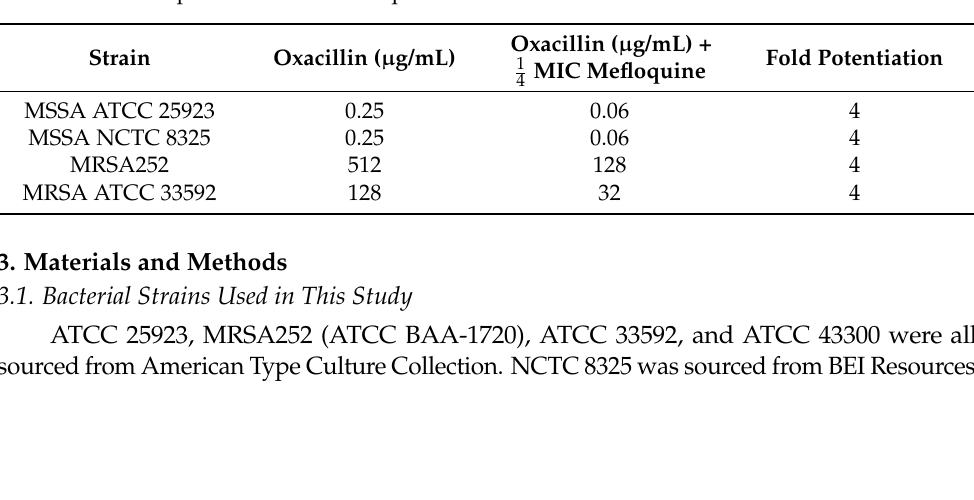
Figure 4. Compound effects on the cytoplasmic membrane of S. aureus. ( A ) SYTOX Green uptake induced by melittin or mefloquine treatment in ATCC 25923. Concentrations are indicated as fold of the MIC. The solid gray line indicates the RFU of the DMSO control. Signals are reported after 20 min of treatment at the indicated concentrations. ( B ) Laurdan GP after 5 min treatment with indicated concentrations of melittin or mefloquine in ATCC 25923. The solid gray line is the GP of the DMSO control, and the dotted line is the average GP of ATCC 25923 treated with 50 mM of the membrane fluidizer benzyl alcohol. Table 2. Oxacillin potentiation of mefloquine in S. aureus